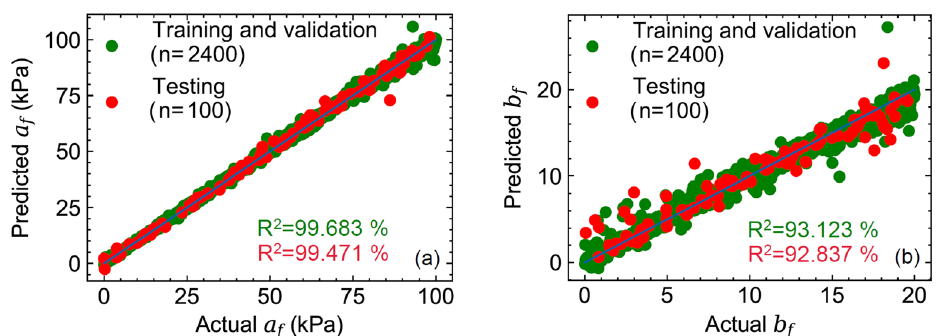
Figure 9. Actual and predicted values of myocardial properties: (a) a f (b) b f . Training/validation and testing datasets included n=2400 and n=100 sample points,